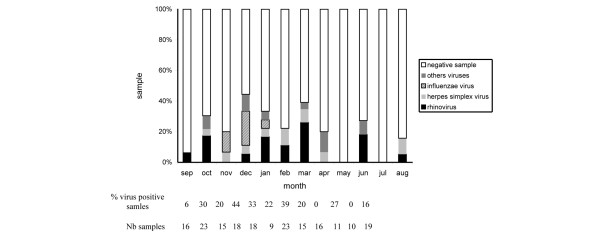
Viral endemic periods. Nb samples, number of samples.